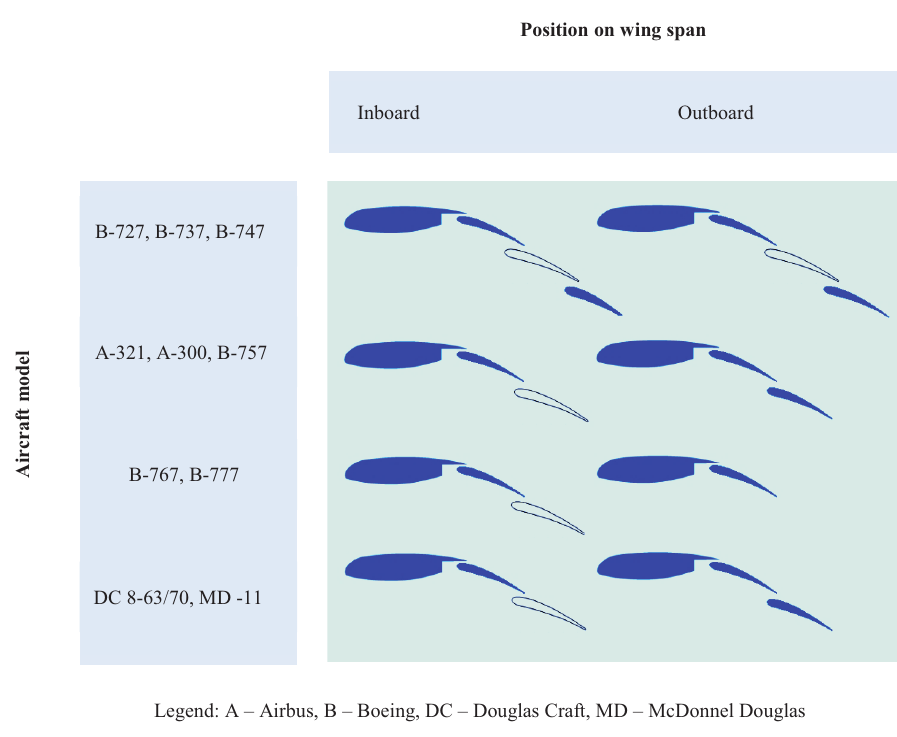
Figure 4. Schematic view of trailing edge flap/slat configurations used in Boeing, Airbus and McDonnel Douglas